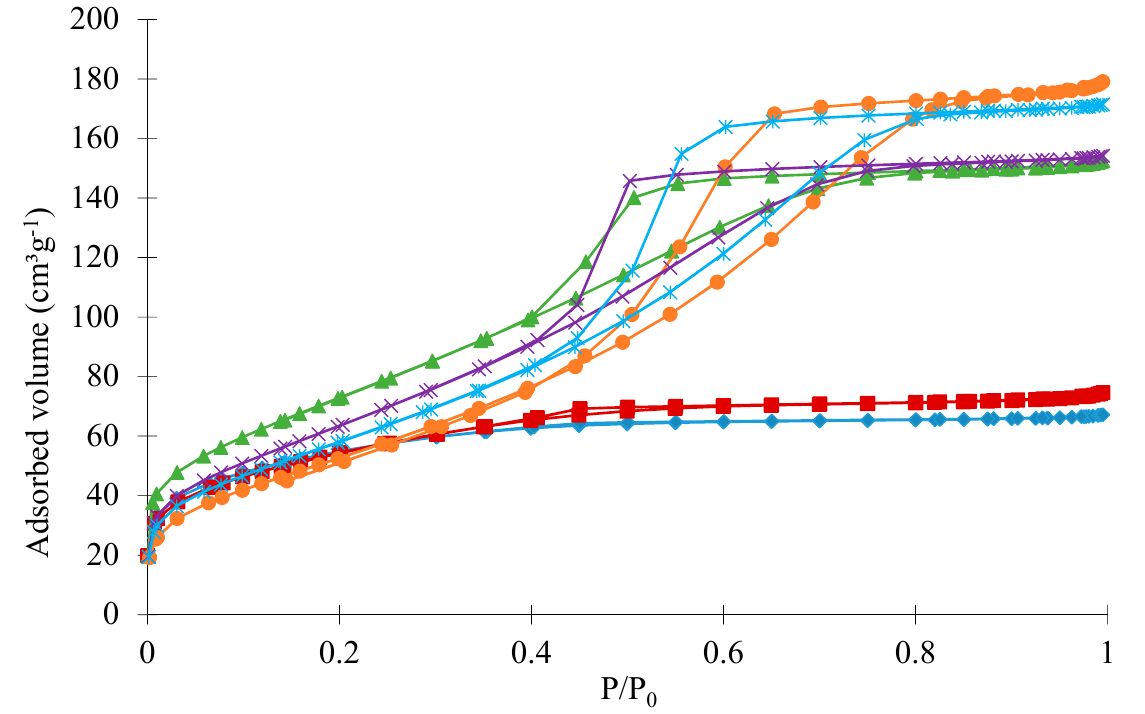
Figure 4. Nitrogen adsorption–desorption isotherms of samples: ( ♦ ) pure TiO 2 , ( ■ ) TiO 2 /Zr2.8, ( ▲ ) TiO 2 /U4, ( ● ) TiO 2 /U4/Zr2.8, (×) TiO2/N42, and (*) TiO 2 /N42/Zr2.8.